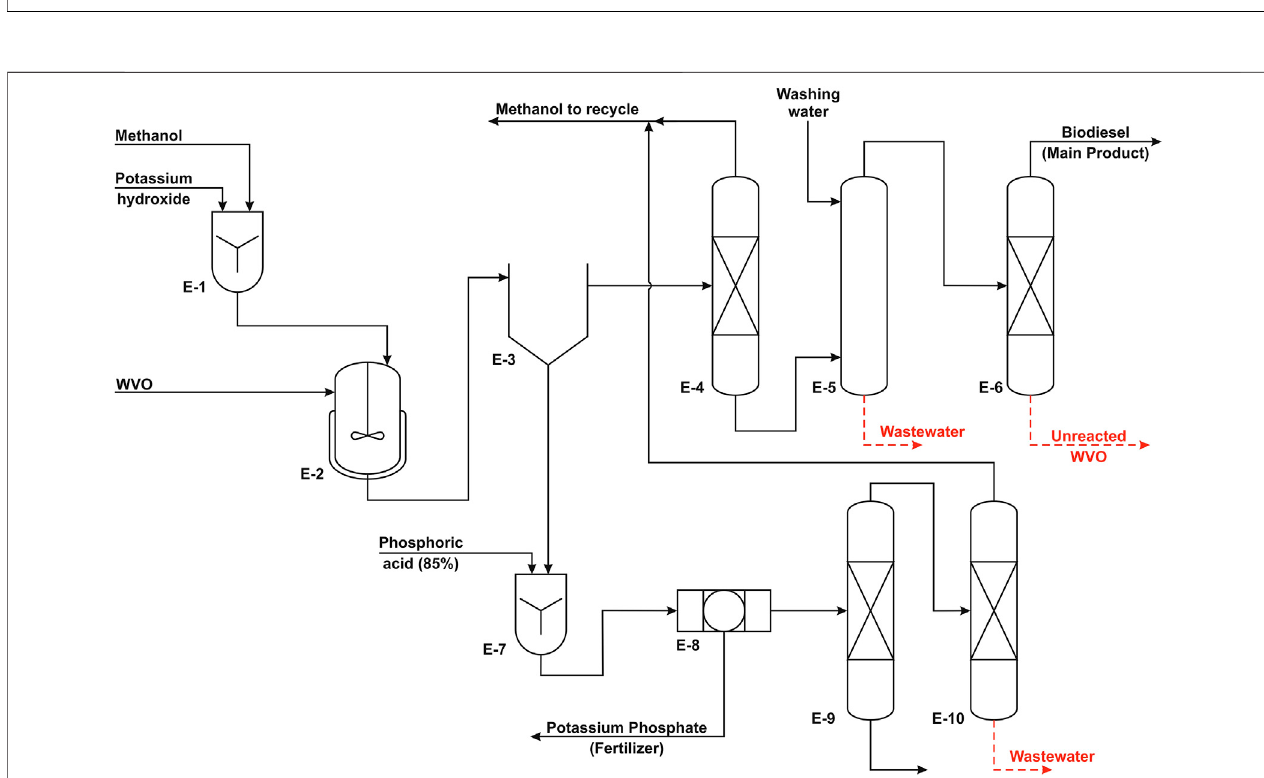
FIGURE 2 | Process fl ow diagram of the homogeneous process (adapted from Al-Sakkari et al., 2018a).